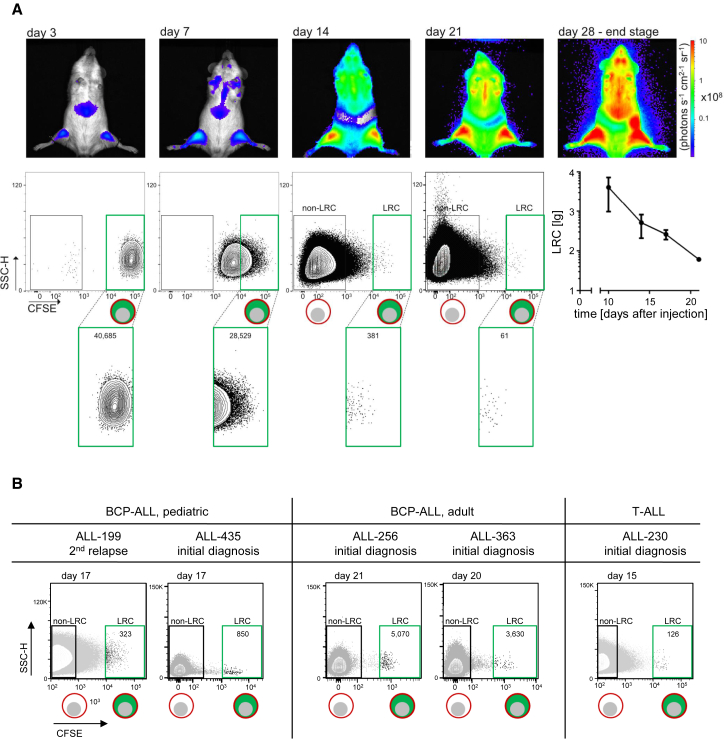
A Rare, Long-Term Dormant Subpopulation Exists in ALL PDX Cells(A) 107 CFSE-stained PDX ALL-265 cells were injected into each of six mice; bioluminescence in vivo imaging was performed prior to quantifying LRC in one mouse per time point; LRC numbers are indicated and summarized in the line graph as a mean of up to ten mice ± SE.(B) Identification of LRC in PDX cells from all different ALL patients. Experiments were performed as in (A).See also Figure S2.